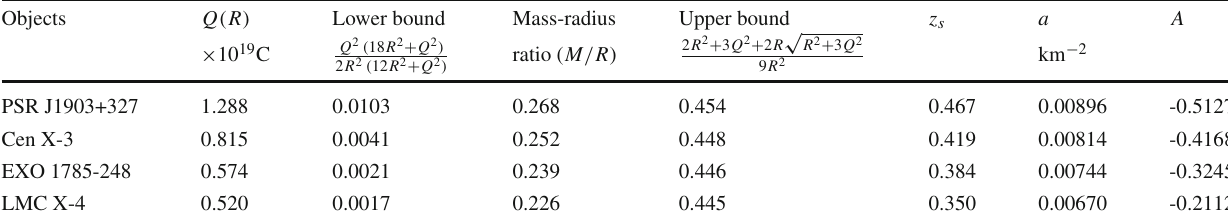
Table 2 Comparative study of lower bound, Mass-radius ratio, upper bound, compactness ( u = M eff / R ) and surface red-shift of the star for